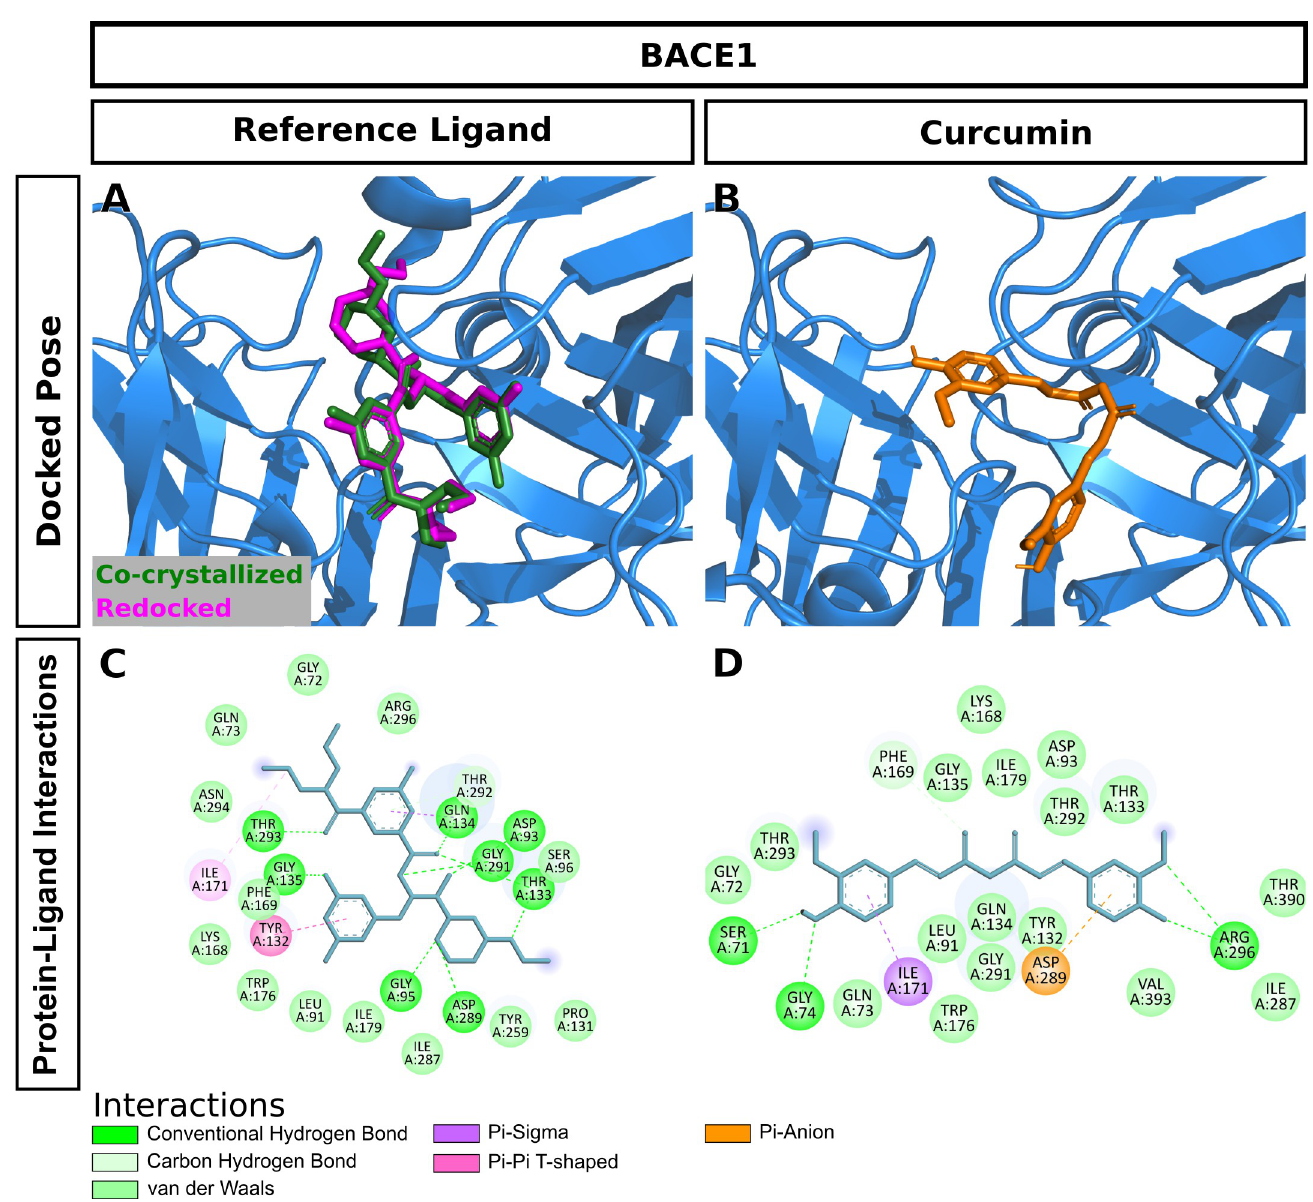
Fig 13. Molecular docking of curcumin to BACE1. (A) Redocking of the bound ligand. (B) Docking pose of curcumin. (C) Interactions of the bound ligand with the protein. (D) Predicted interactions of curcumin with the protein.